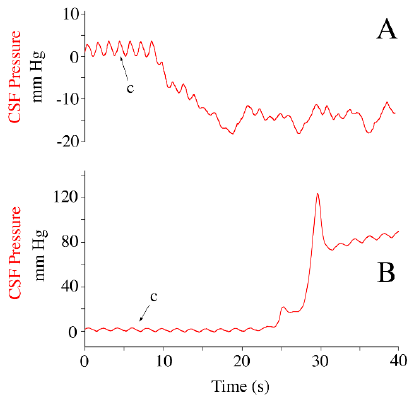
Figure 10. The influence of body tone on CSF pressure. During the locomotor trials (post-recovery) the alligators could shift their body tone, most commonly by lowering their body onto, or elevating it off of, the substrate. ( A ) a decrease in baseline CSF pressure (red) occurring as the alligator elevated up off of the substrate (and decreased the compression on its trunk). ( B ) a sharp increase in baseline CSF pressure (red) that occurred when the alligator sprawled out onto the substrate (and increased the compression on its trunk). Note that these changes in baseline CSF pressure were achieved without body movements suggestive of ventilation. c—individual cardiac-related pulsation.